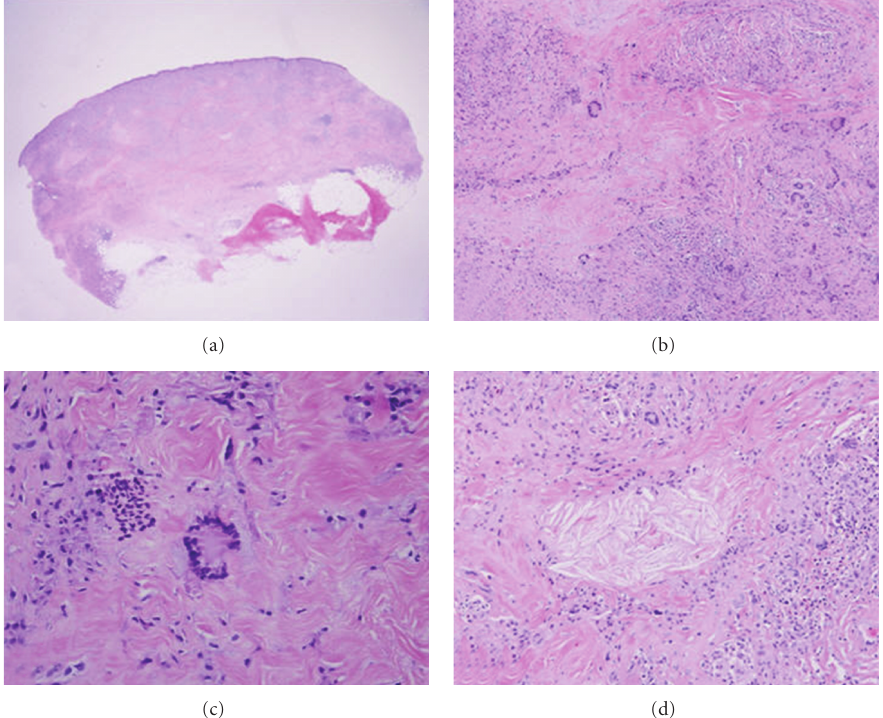
Figure 2: Histopathology (Hematoxylin & Eosin staining) revealed di ff use infiltration from papillary dermis to superficial subcutaneous fat by mononuclear cells (H&Ex12.5) (a). Palisaded granuloma with necrobiosis is also noted (H&Ex200) (b). Xanthoma cells and Touton giant cells (c) and cholesterol clefts (d) are seen